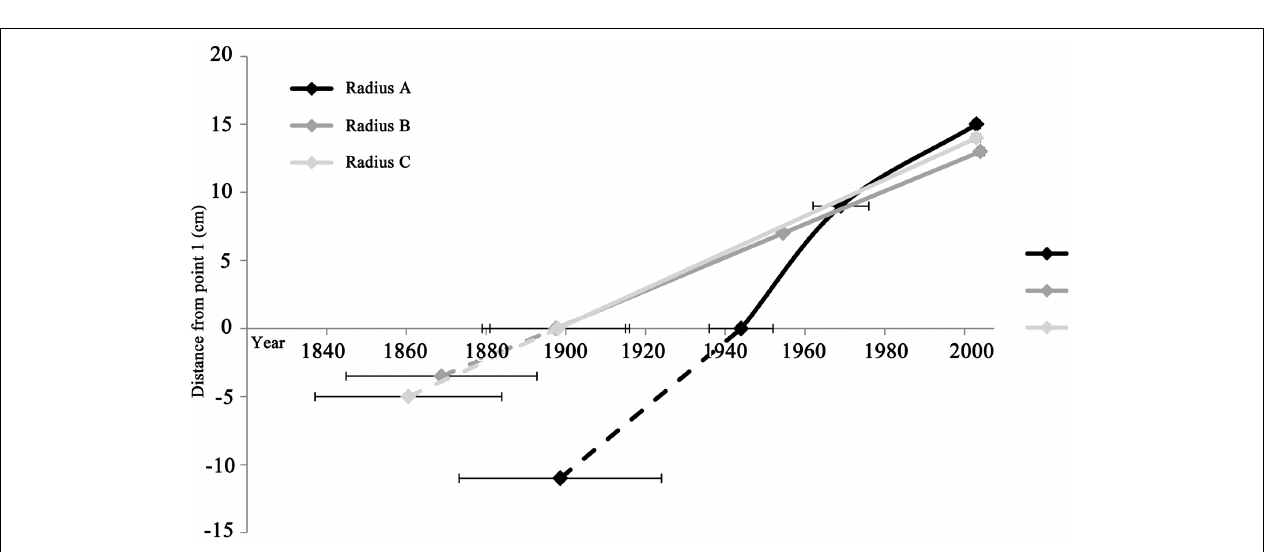
FIGURE 4 | Comparison of growth rates between different radii, represented by the slope of each radius. Although radius C is comprised of only the two extreme points (point 1 and 3), it is shown in order to illustrate the similarity of its slope to radii A and B. Point 1 in all radii is the intercept with the x axis. The dashed lines represent the estimated distance from the edge of the remaining wood within the rotted center to the estimated pith location, and the corresponding averaged pith formation year. Point 3 in all radii is the chronologically latest point, while point 2 is the intermediate in radii A and B.